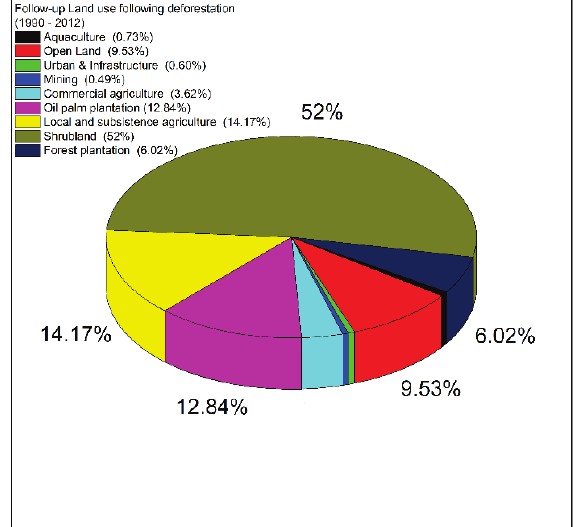
Figure 3 Follow up land use after deforestation 1990 - 2012